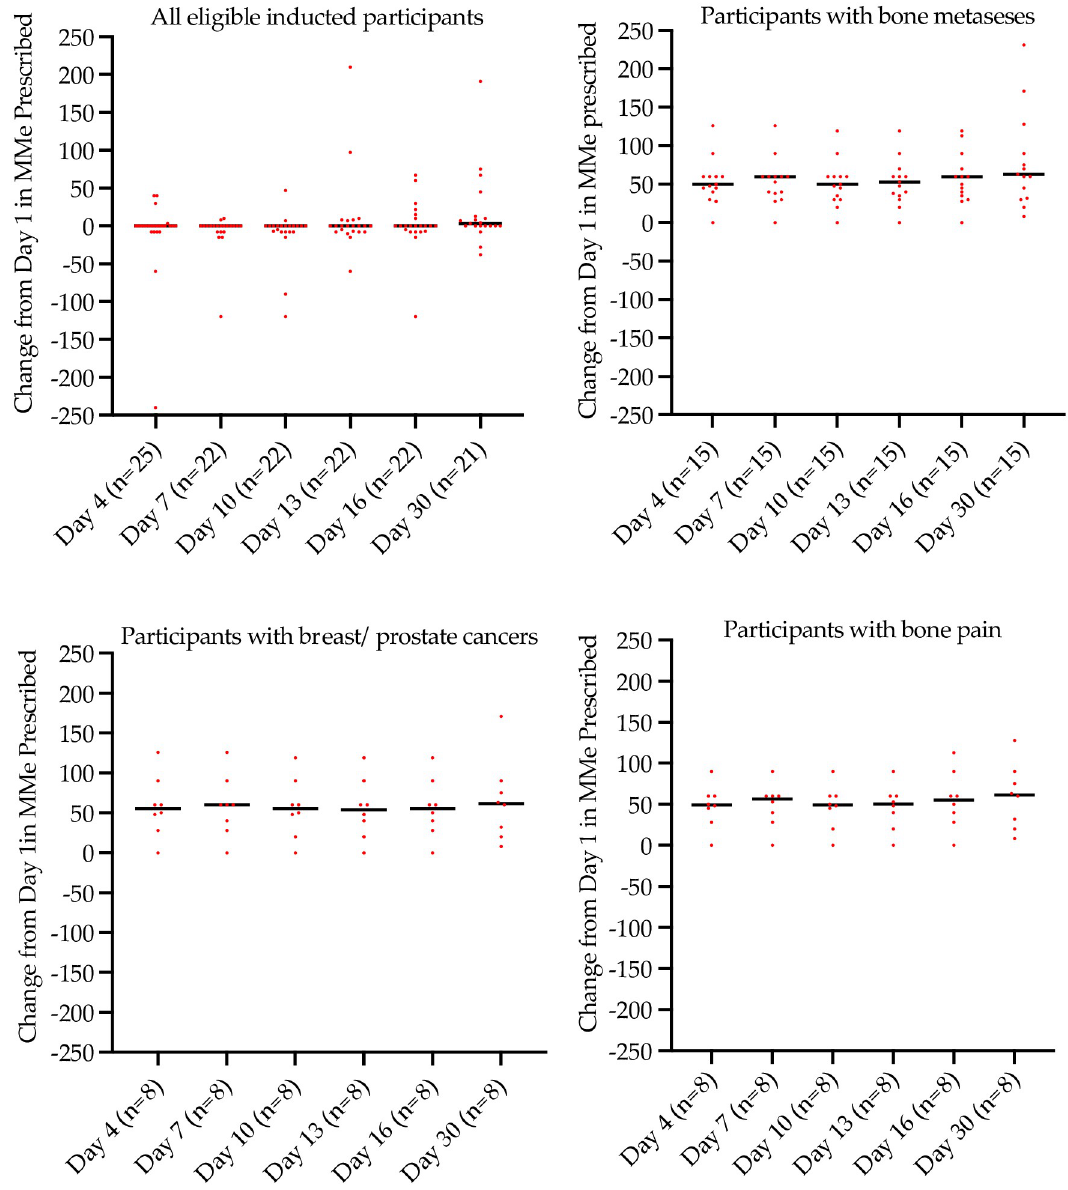
Fig 4. Change in morphine milligram equivalent dose prescribed from day 1. Note, one patient reported highly variable changes in MMeq over the time course of the study (Day 4, -240 MMeq; Day 7–330 MMeq; Day 10–90 MMeq; Day 13 +210 MMeq; Day 16 +30 MMeq; Day 30 +1170 MMeq. Day 7 and Day 30 changes are not depicted on this figure for this